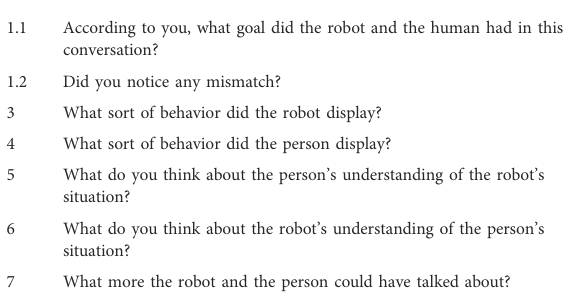
TABLE 1 Interview template for interviews conducted between